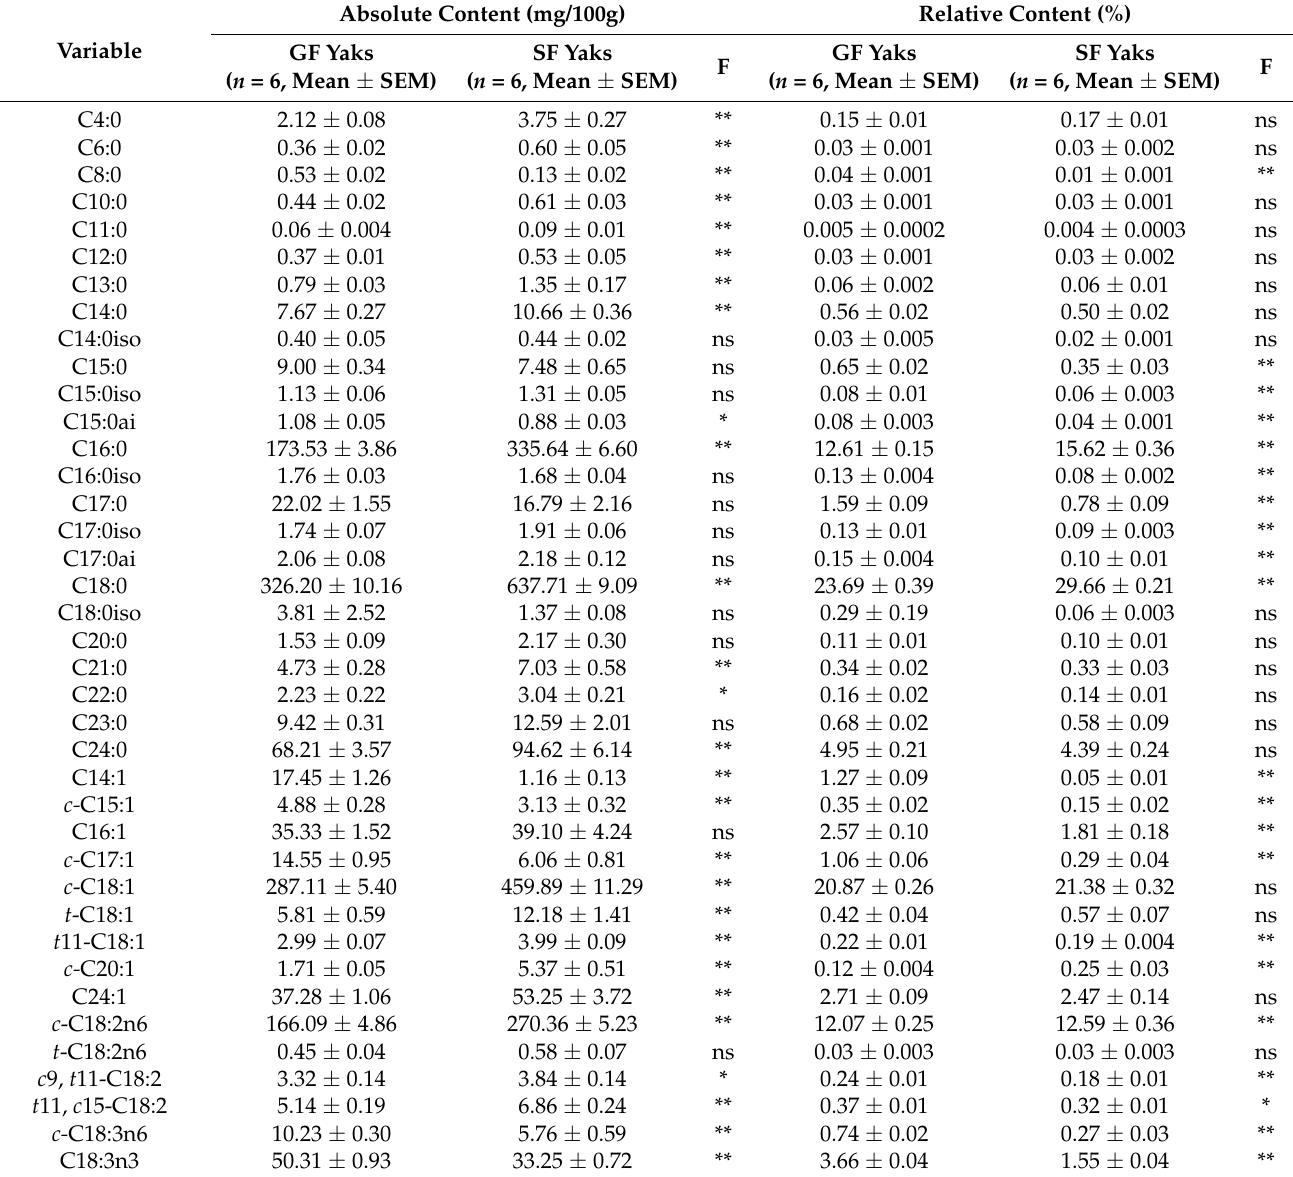
Table 2. The absolute and relative content of fatty acids in yak longissimus dorsi (LD) muscle under stall feeding (SF) and graze feeding (GF)